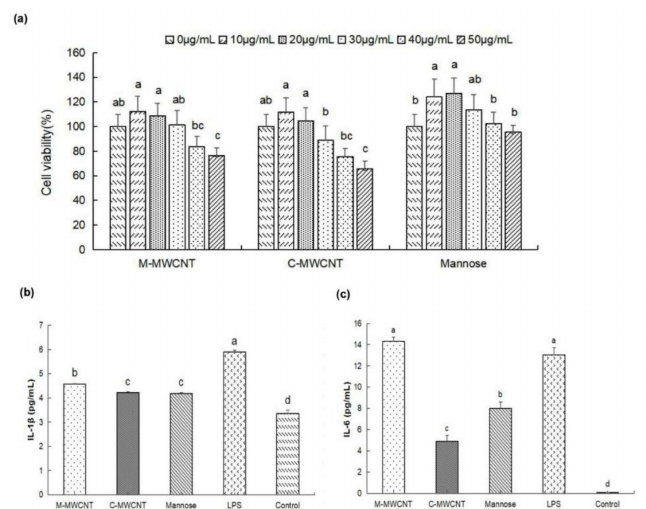
Figure 5. The effects of M-MWCNT on macrophage proliferation and cytokines secretion. ( a ). M-MWCNT, C-MWCNT, and mannose cytotoxicity on macrophages ( a ). IL-1 β secretion levels of macrophages ( b ). IL-6 secretion levels of macrophages ( c ). Significant differences are indicated by different letters (a–f). The data are presented as the mean ± SD ( n = 3) analyzed by one-way ANOVA and then Duncan’s multiple-range tests. Different letters (a, b, c, and d) above each group of bars indicate statistically significant differences ( p <